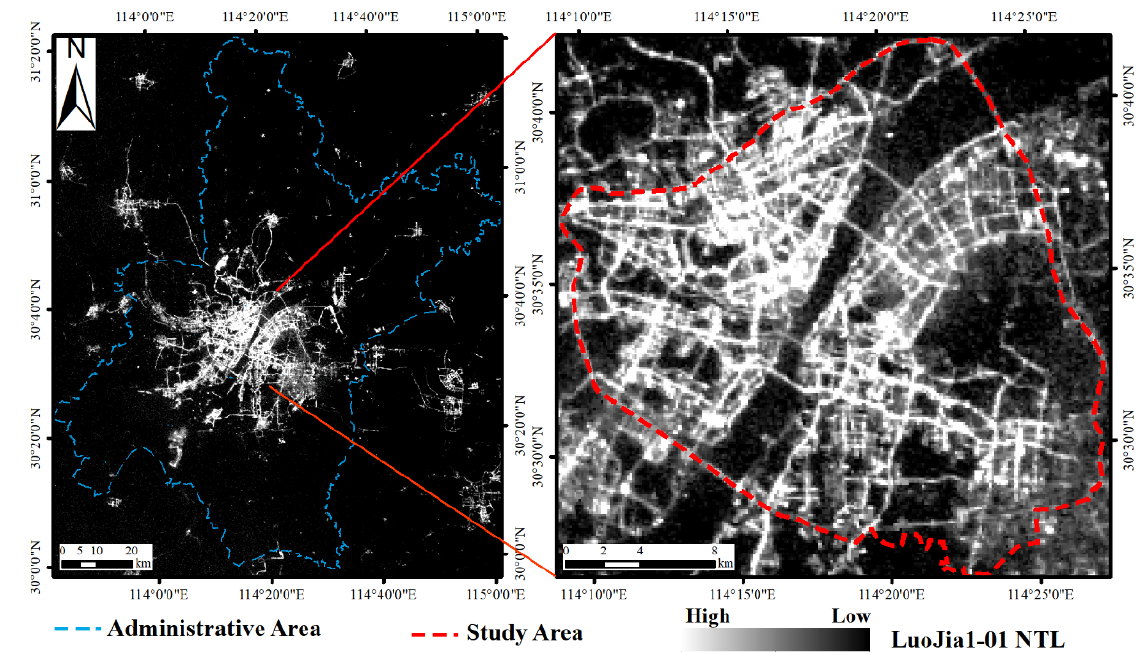
Figure 1. NTL image of Luojia 1-01 in the study area. Table 1. Comparison of different NTL